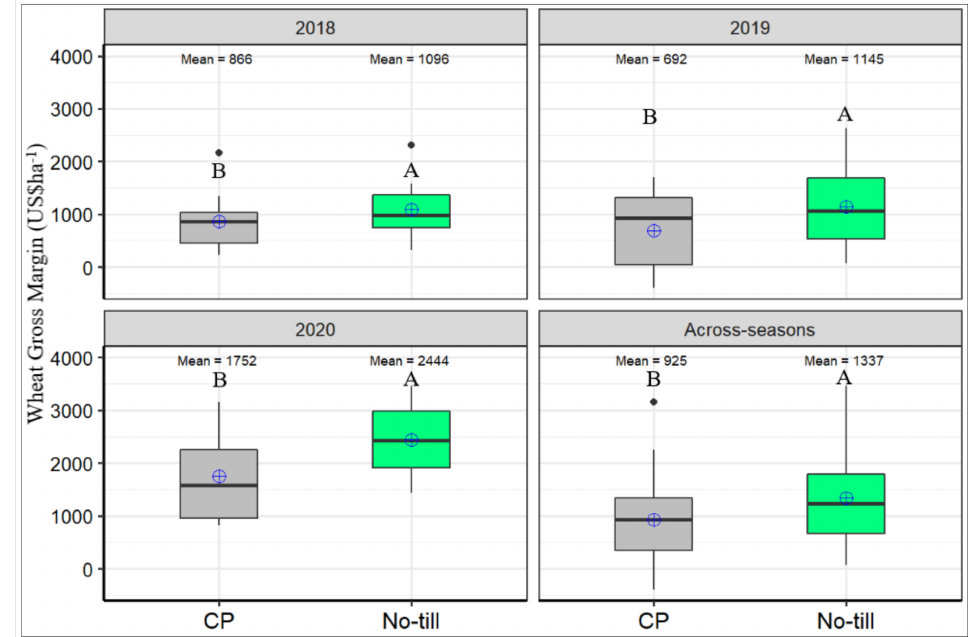
Figure 10. Gross margins from conventional practice and NT treatments under wheat cropping system in 2018, 2019, 2020 and across the growing seasons. Means with different letters (A, B) in the same season are significantly different at p <